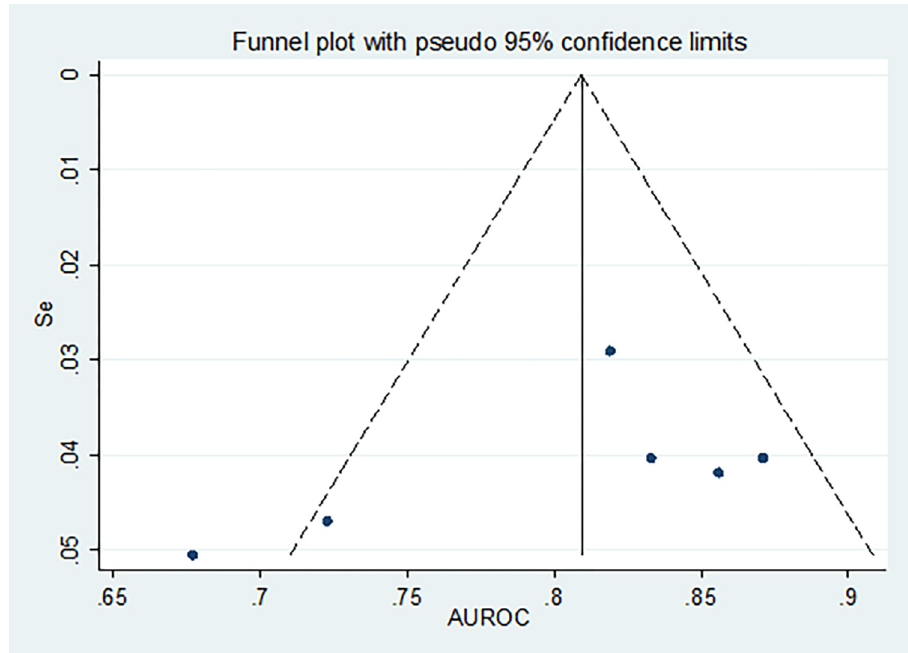
Fig 6. A funnel plot showing the publication bias.